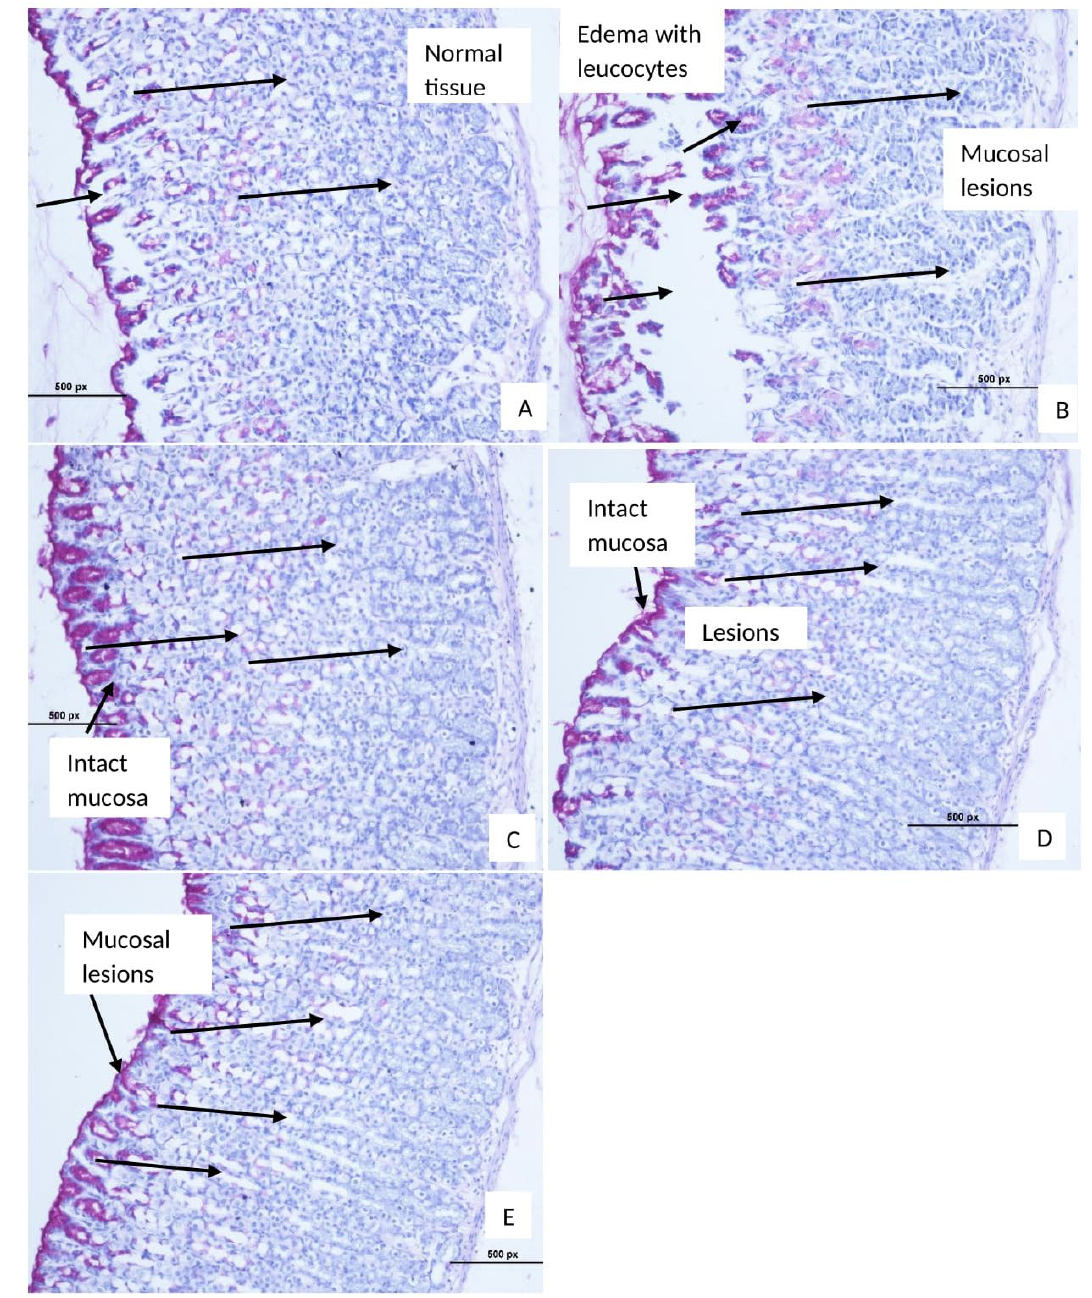
Figure 5. Effect of p -Cymene on microscopical observation of PAS glycoprotein staining ( A – E ) of the gastric mucosa in ethanol-induced gastric ulcers in rats. ( A ) Normal group—normal gastric mucosal structure and no signs of damage; ( B ) ulcer control group—severe damage to gastric mucosa and mild PAS stain (magenta color); ( C ) omeprazole group—insignificant damage and intensive PAS staining of gastric mucosa; ( D ) p -Cymene 30 mg/kg—mild to moderate damage of gastric mucosa with mild PAS stain of gastric mucosa; ( E ) p -Cymene 60 mg/kg—mild damage of gastric mucosa and with moderate PAS stain of gastric mucosa (PAS stain, magnification 20×).